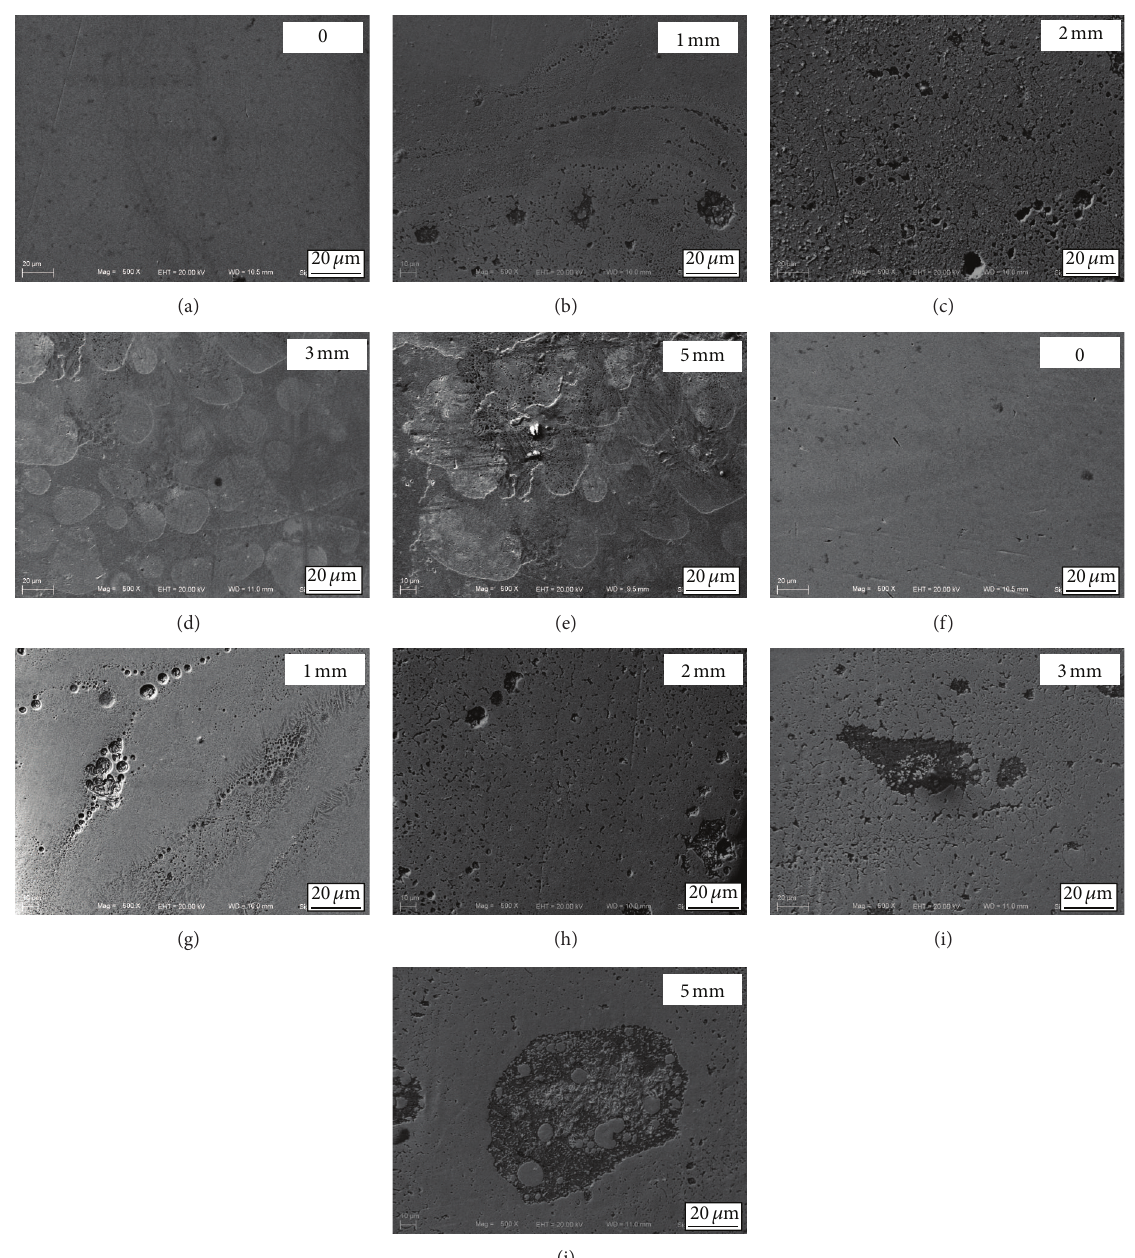
Figure 6: SEM surface morphologies of unstressed and stressed composite arch wires immersed in artificial saliva with different pH: ((a)–(e)) pH = 4.0; ((f)–(j)) pH =